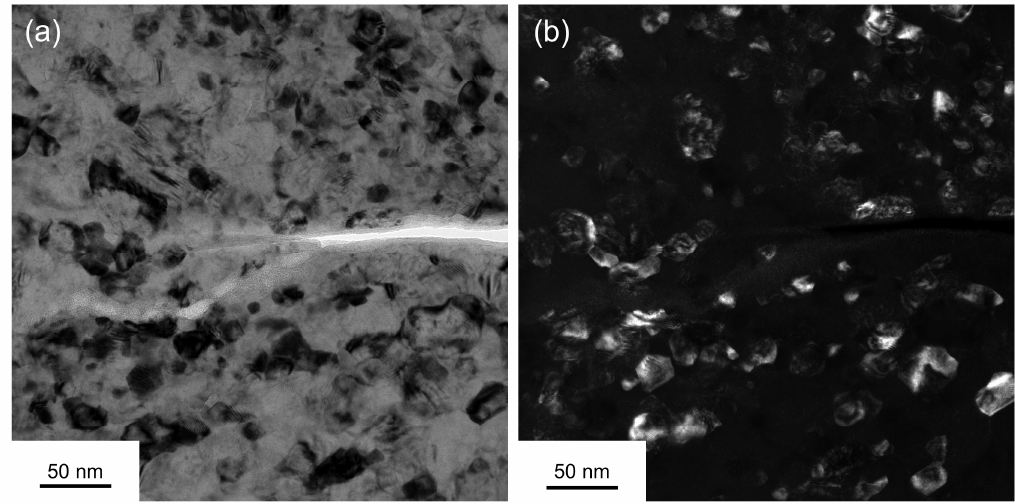
Figure 10. TEM micrographs of a butterfly wing: ( a ) bright-field micrograph; ( b ) dark-field micrograph.